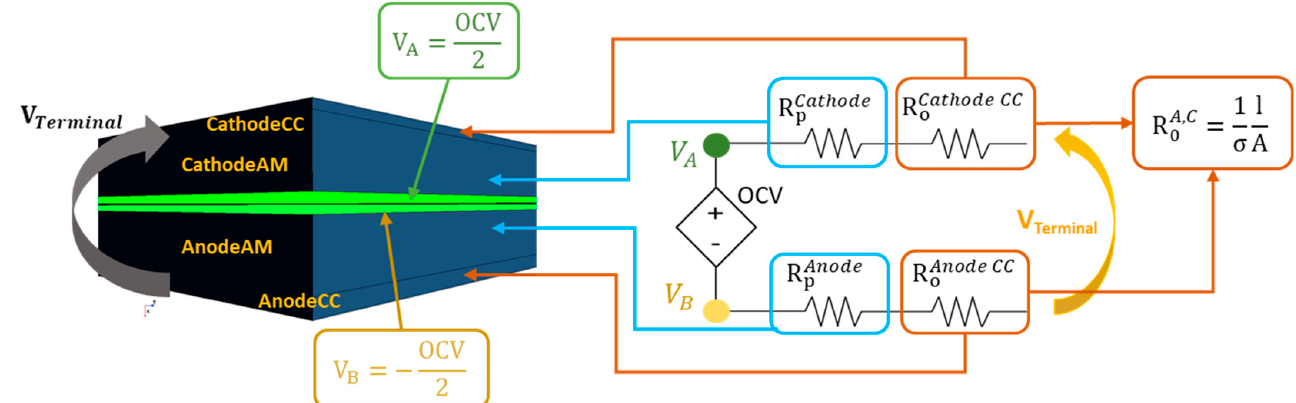
Figure 2. Transfer of the discretization strategy from the equivalent circuit model to the volumetric finite elements model. Rp is the polarization resistance, Ro is the ohmic resistance, CC stands for “current collector”, σ is the electrical conductivity, l is the layer thickness and A is the block surface section. The parallel RC element has been replaced by an equivalent single resistor: Its values depend on the variation in the voltage drop, which introduce the desired capacitive effect.